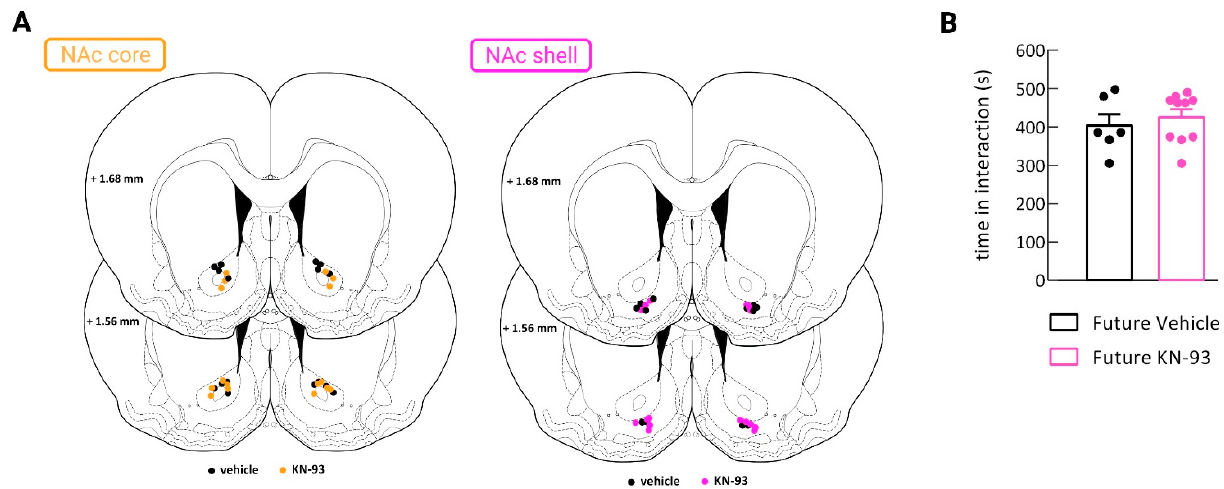
Figure A2. ( A ) Representative image of the infusion sites in the NAc core or shell for rats infused with either vehicle or the CaMKII inhibitor KN-93. ( B ) Time of direct contact in paired rats that received an infusion in the NAc shell during the last social interaction conditioning session. “Future Vehicle” and “Future KN-93” groups refer to the rats that received an infusion of Vehicle or KN-93, respectively, in the NAc shell, before being tested for CPP, p = ns; n = 6–10. Results are presented as mean ± SEM.